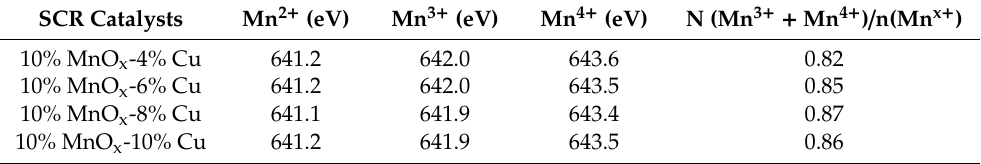
Figure 3. The XPS pattern of Mn-Cu / ZSM5 catalysts with di ff erent loadings of 4%, 6%, 8%, and 10% Cu, respectively. Table 2. The Mn valence binding energy distribution of Mn-Cu / ZSM5